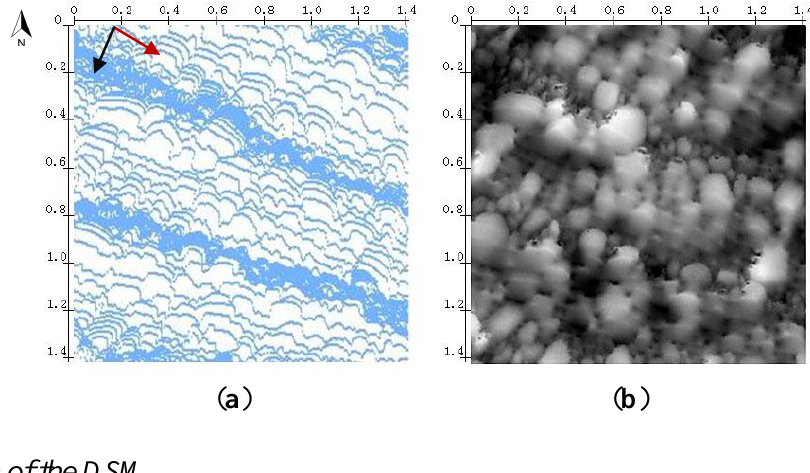
the scan profiles, the black arrow marks the direction of the scanning track (platform track). The switching of footsteps during data collection produces lower profile spacing (higher scan profile density) along the scanning track due to a lower platform speed at those moments. ( b ) Digital surface model (DSM) generated from the MLS points.